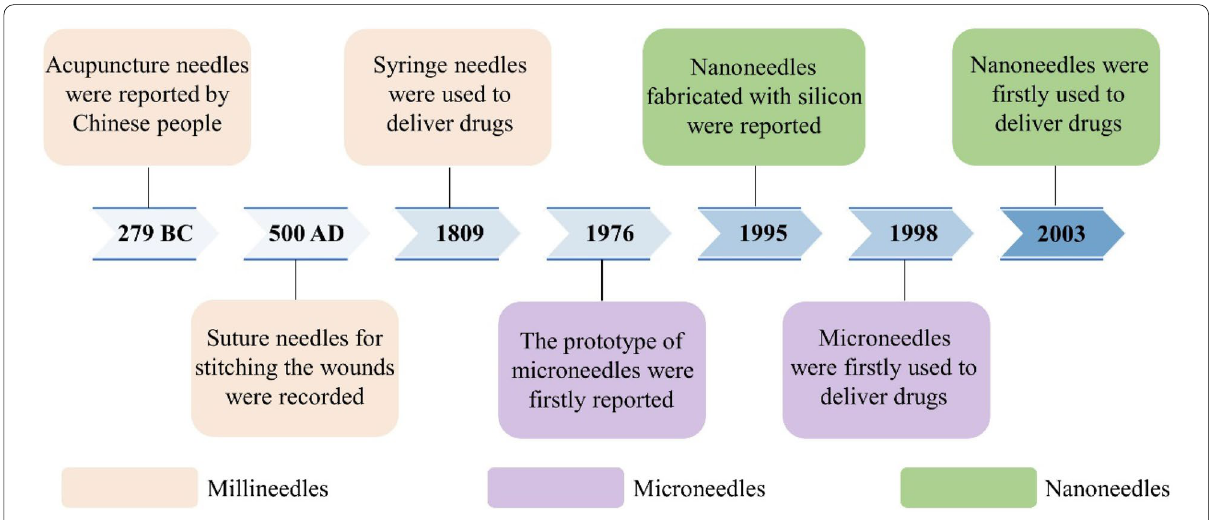
Figure 1 The typical development history of nano/micro/milli